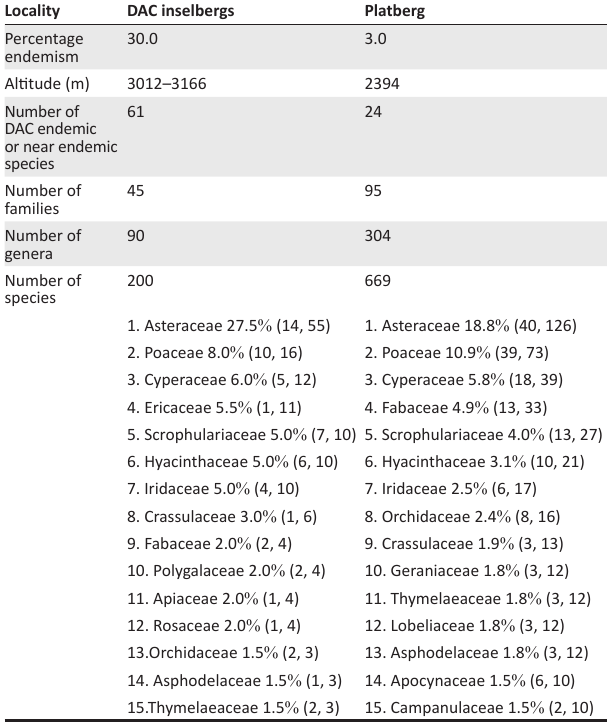
TABLE 4: A floristic comparison of the Drakensberg Alpine Centre inselbergs with Platberg.